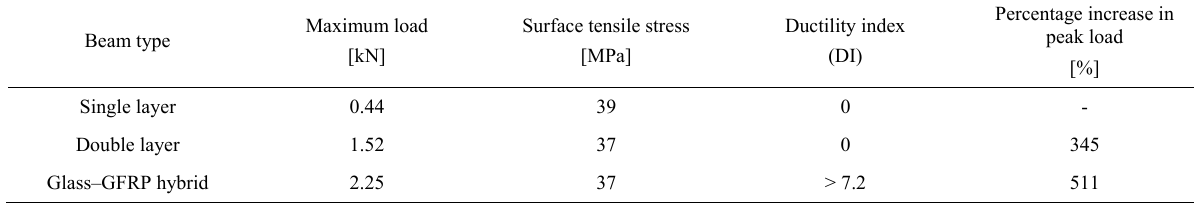
Table 2: Load, ductility index and percentage increase for different types of